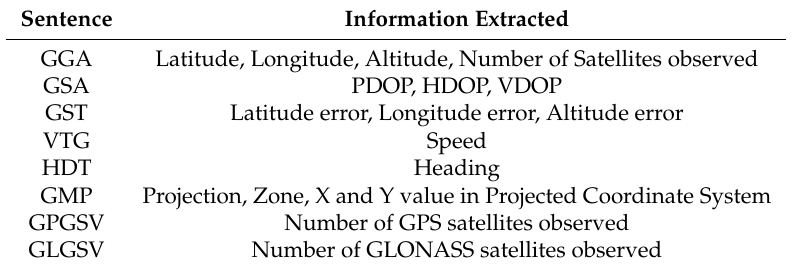
Table 2. Information extracted from National Marine Electronics Association (NMEA)